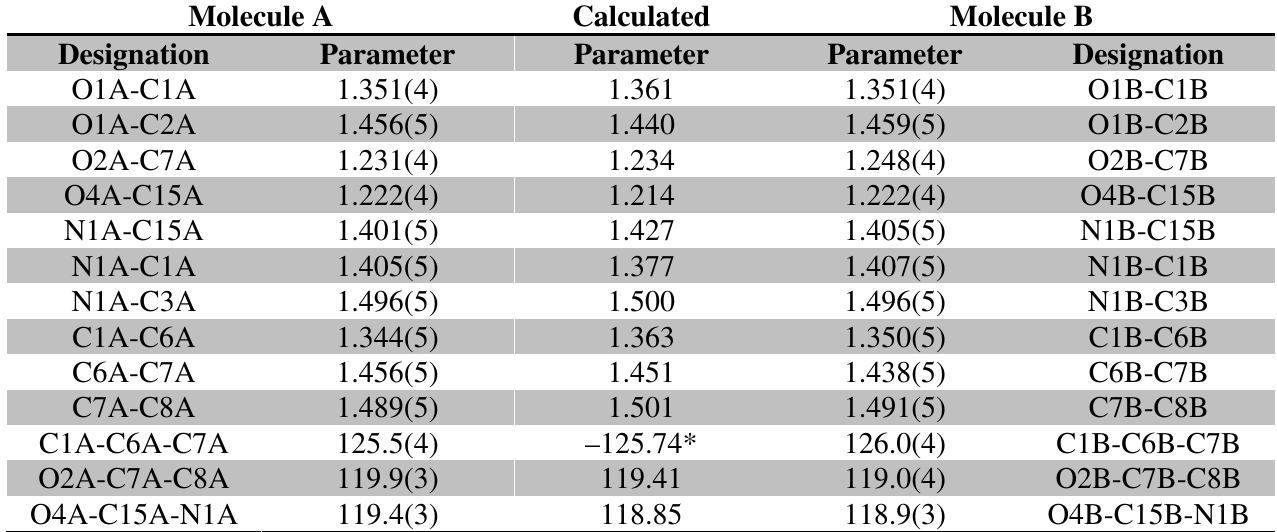
Table 1. Selected bond lengths (Å) and angles (°) for observed unit cell Molecules A and B (standard deviations in parentheses) and their respective calculated parameters (DFT B3LYP 6-311++G**).